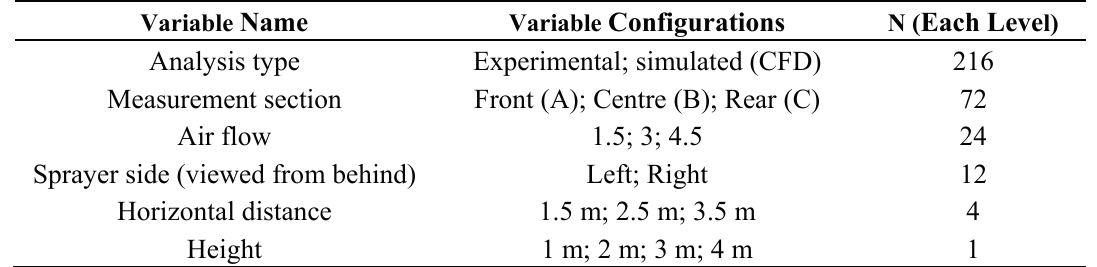
Table 2. Variables affecting air velocity values determined with CFD model. N: number of